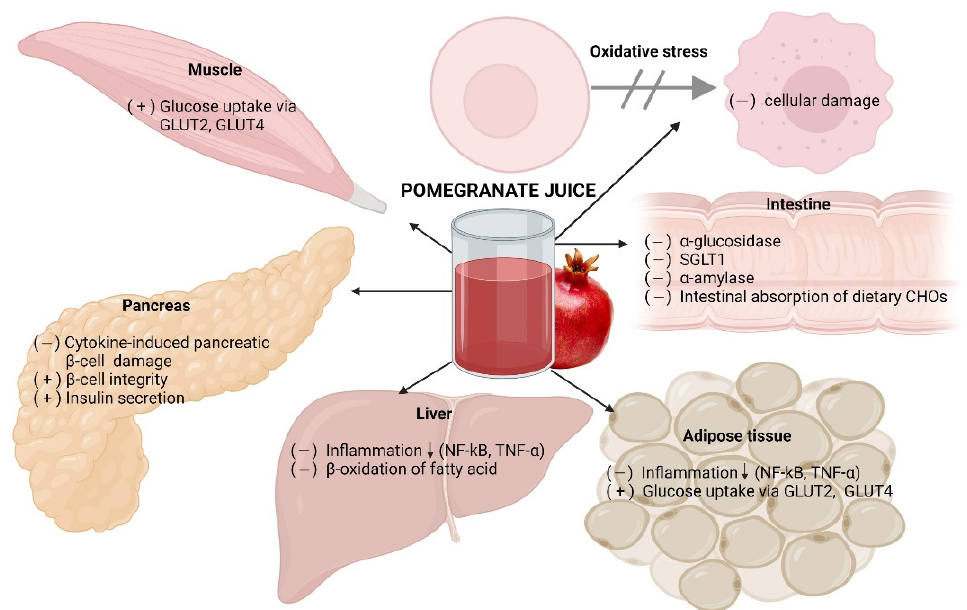
Figure 3. Potential mechanisms of pomegranate juice or its extracts to improve glucose homeostasis.